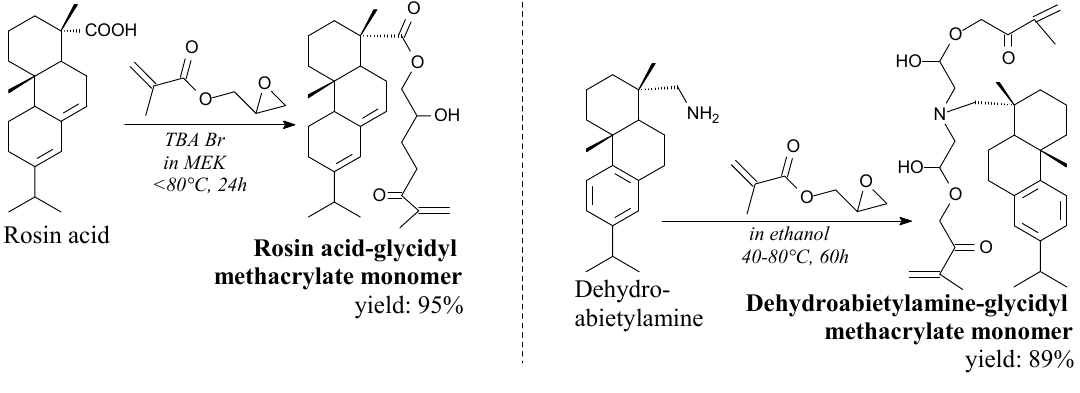
Scheme 15. Synthesis of rosin-based glycidyl methacrylate monomers.